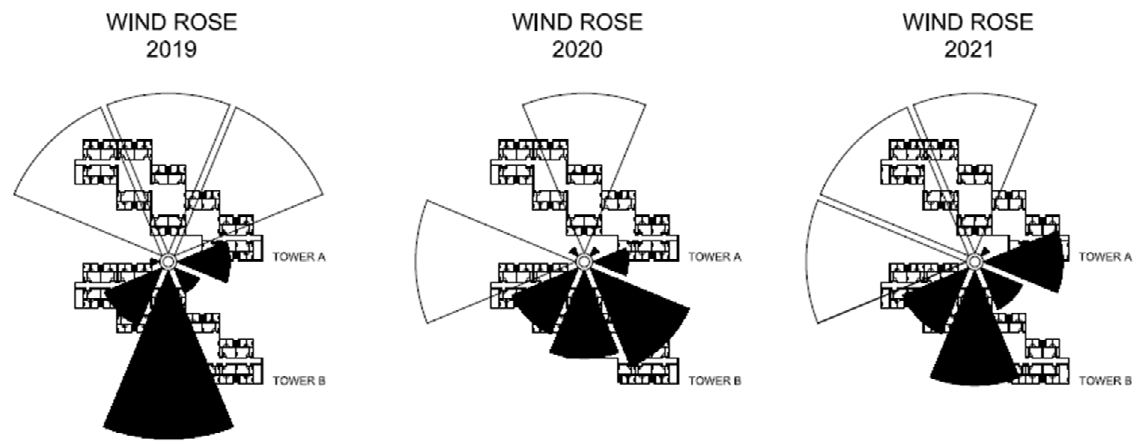
Figure 3. Wind rose data for the last 3 years.